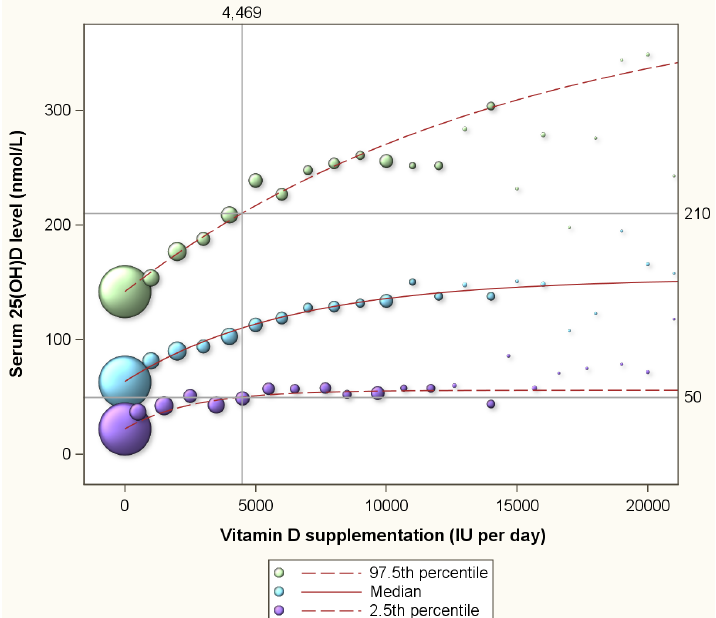
Figure 2. The median and 2.5th and 97.5th percentiles of serum 25(OH)D concentrations by vitamin D supplementation among 11,693 healthy participants of a preventive health program in Canada. Note: The 2.5 percentile line depicts 25(OH)D concentrations for any given vitamin D supplementation dose with 2.5% of all expected 25(OH)D responses to have values below the line, and 97.5% to have values above the line. The 97.5 percentile line depicts 25(OH)D concentrations for any given vitamin D supplementation dose with 97.5% of all expected 25(OH)D responses to have values below the line, and 2.5% to have values above the line. The area between the 2.5 percentile line and the 97.5 percentile line depicts the 95% prediction interval of 25(OH)D concentrations for any given vitamin D supplementation dose. The median, the 2.5th and 97.5th percentiles were estimated through quantile regression, a statistical approach that accommodates the clearly visible skewness in the distribution of 25(OH)D